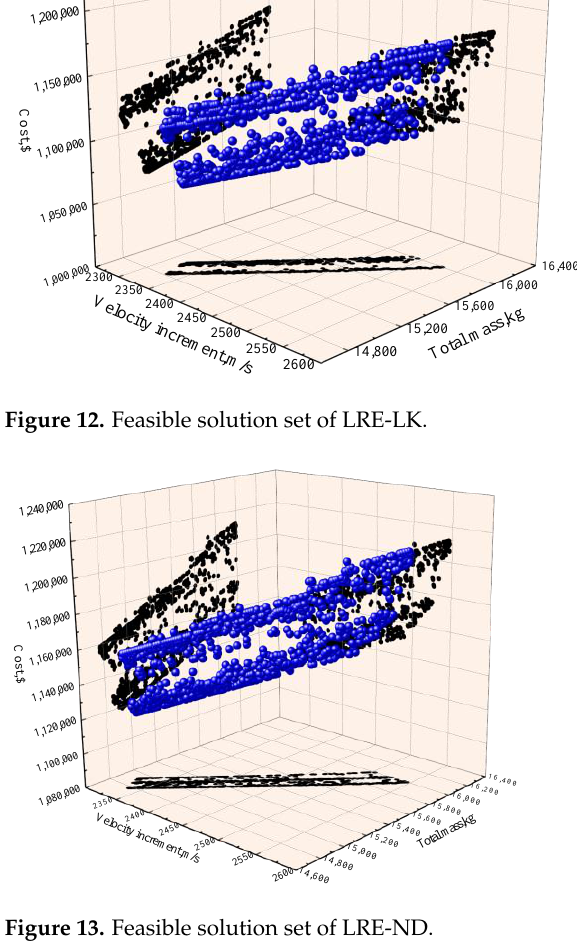
Figure 13. Feasible solution set of LRE-ND.